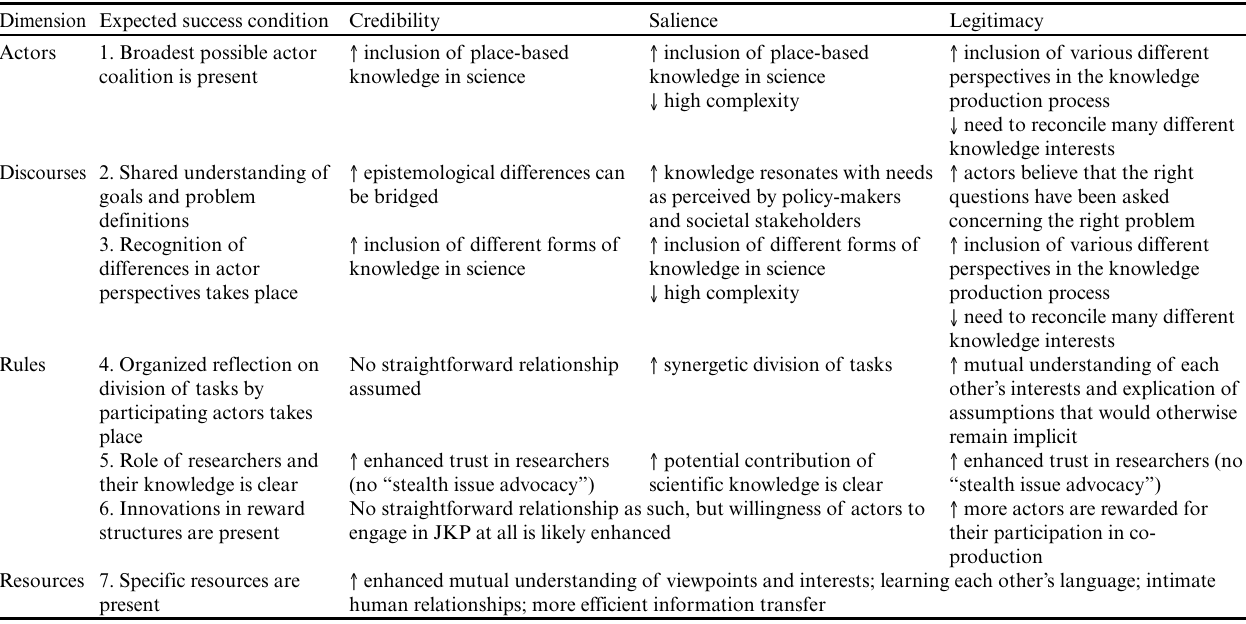
Table 2. Expected relationship between success conditions of joint knowledge production (JKP) projects and the perceived credibility, salience, and legitimacy of the knowledge produced.† Adapted from Hegger et al. (2012 a: